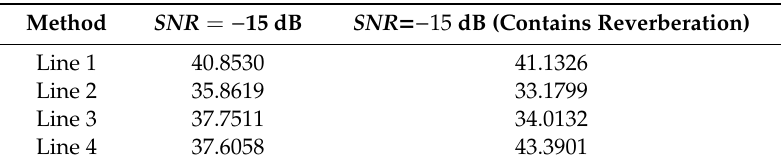
Table 1. Comparative results of DOA (40 ◦